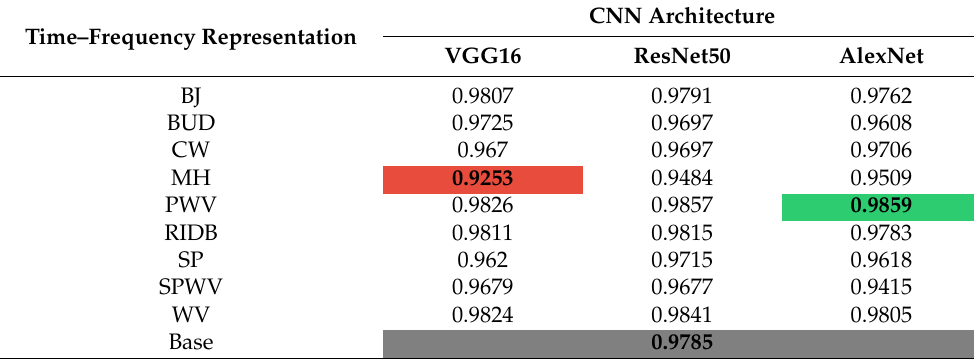
Table 4. The results of model evaluation using the area under the receiver operating characteristic curve measured on the test dataset. Each time–frequency representation is coupled with a convo- lutional neural network. The best performing combination is marked in green, while the worst performing one is marked in red. The results of the base model are marked in